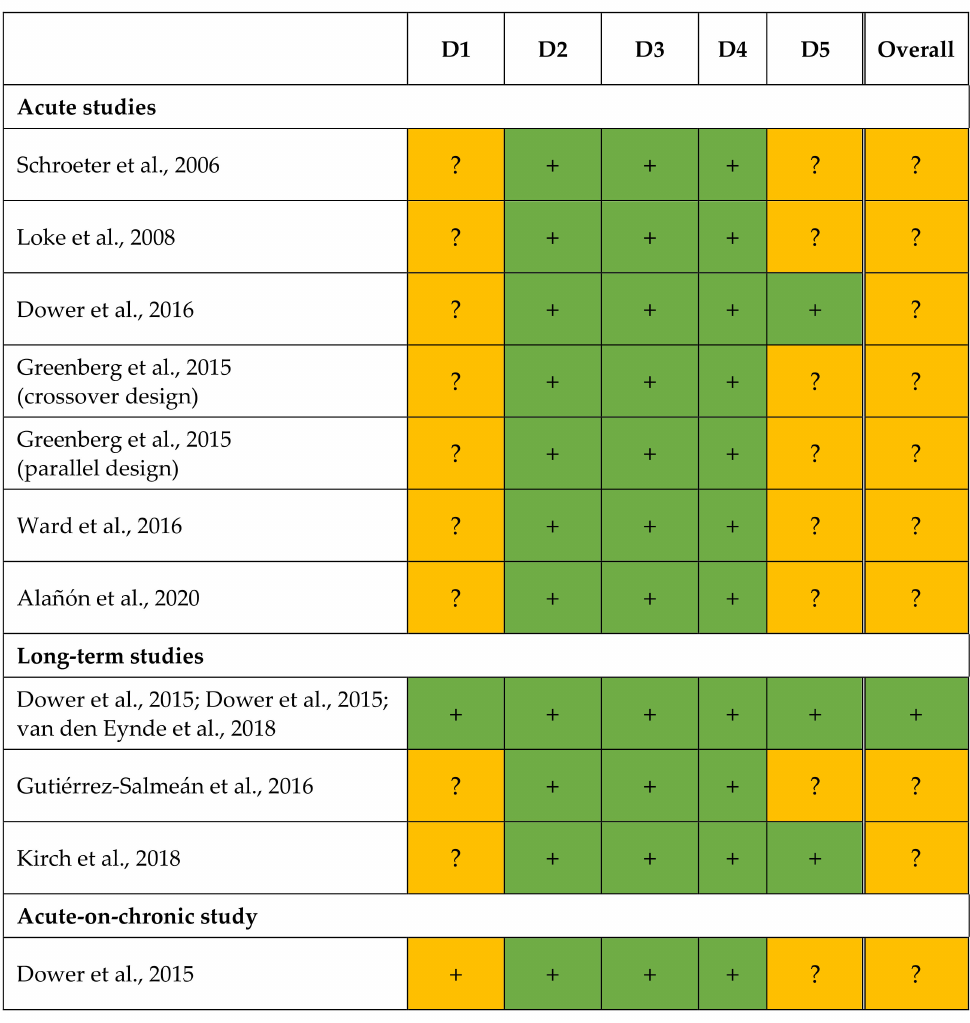
Figure 2. Results of the risk of bias assessment according to the revised Cochrane risk of bias 2 tool for randomized trials [21]. + low risk, ? some concerns, – high risk. D1, bias arising from the randomization process; D2, bias due to deviations from intended interventions; D3, bias due to missing outcome data; D4, bias in measurement of the outcome; D5, bias in selection of reported result